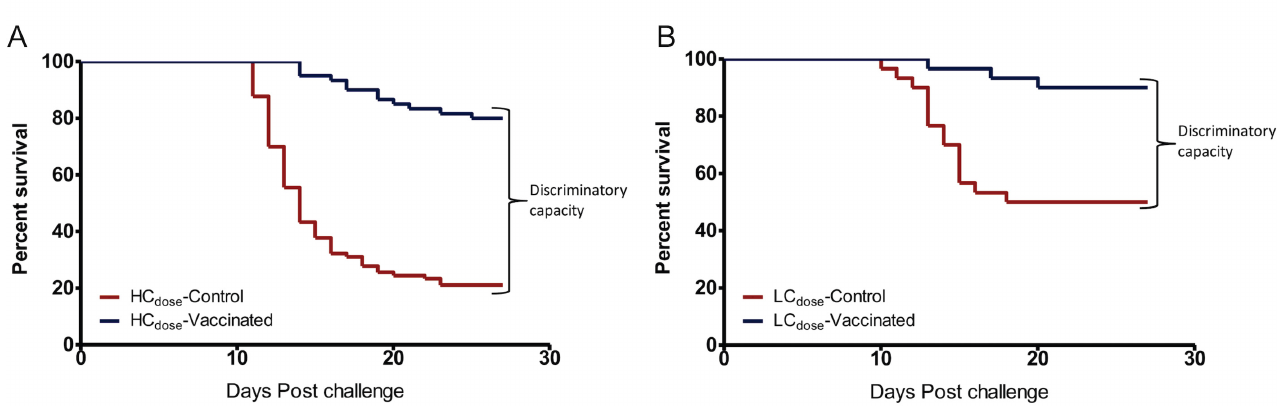
Fig 1. High and low virus challenge dose. Kaplan Meyer ’ s (KM) survival analysis of Atlantic salmon challenged using a high and low challenge dose carried out using strain NVI015-TA (Study II). (A) KM survival analysis for the high challenge dose (HC dose ), 1x10 7 TCID 50 /fish. (B) KM survival analysis for the low challenge dose (LC dose ), 1x10 5 TCID 50 /fish. Fig 1A shows a wider discriminatory capacity (DC > 58%) compared to Fig 1B (DC = 40%) between the vaccinated and unvaccinated control